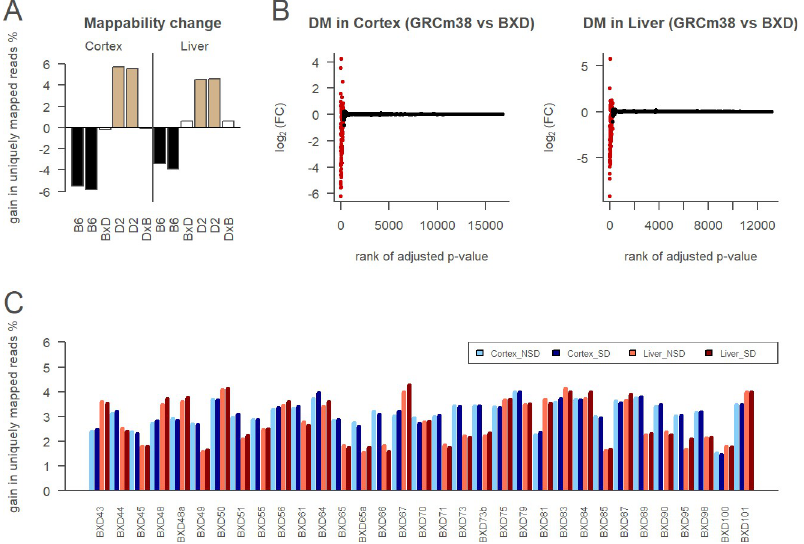
Fig 3. Line-specific references strategy. A. Relative mappability of customized D2-specific reference (GRCm38 modified with D2-specific indels and SNVs from dbSNP) compared to GRCm38 on parental and F1 samples with exact matches. Samples are all NSD. Colors indicate genetic of the samples: B6 (black), D2 (light brown), and F1 (white) between B6 and D2 strains. The F1 samples are BxD if the mother is B6 and the father is D2 (as for the BXD lines), or the reverse for DxB. B. Differential mapping (DM) analysis of BXD-specific references compared to GRCm38, in the cortex (left) or in the liver (right). Genes are classified as DM genes if the FDR adjusted p-value < 0.05 (red) or non DM genes otherwise (black). C. Relative mappability of BXD-specific references (GRCm38 modified for each BXD line with GeneNetwork genotypes and imputed variants) compared to GRCm38 on BXD samples with exact